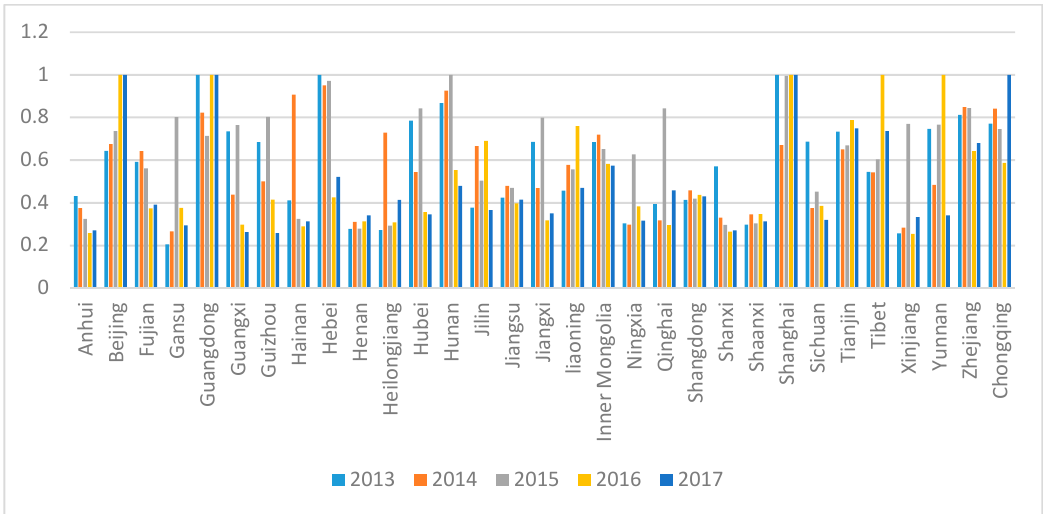
Figure 2. Total efficiency scores of provinces, municipalities, and autonomous regions from 2013 to Figure 2. Total e ffi ciency scores of provinces, municipalities, and autonomous regions from 2013 2017. to